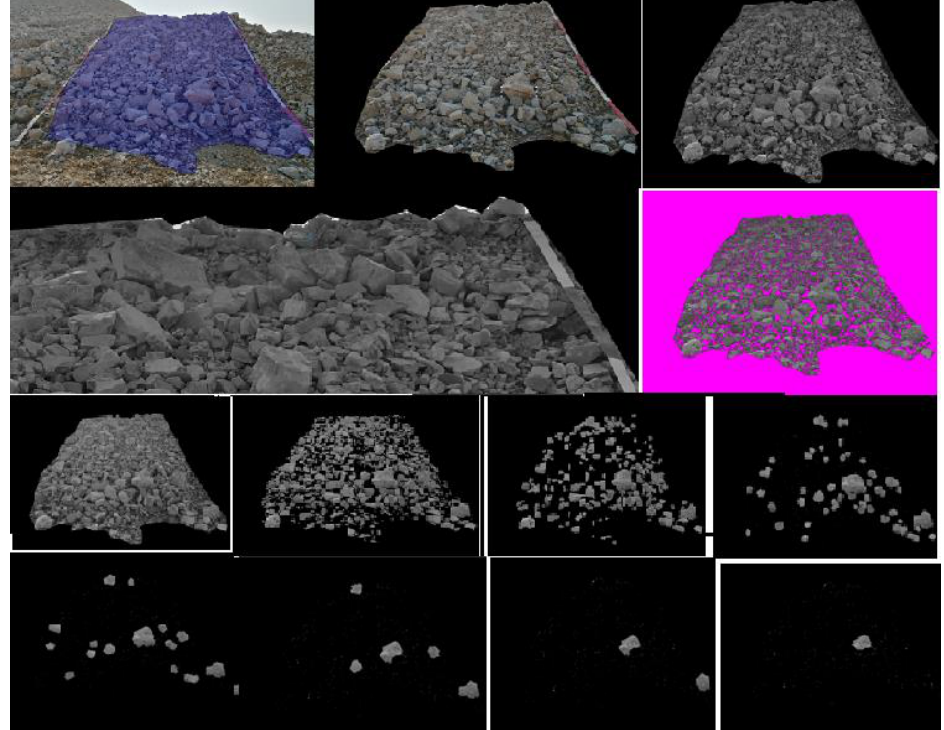
Figure 15. Stages of rock fragmentation recognition in the Power Sieve3 software (PS3).